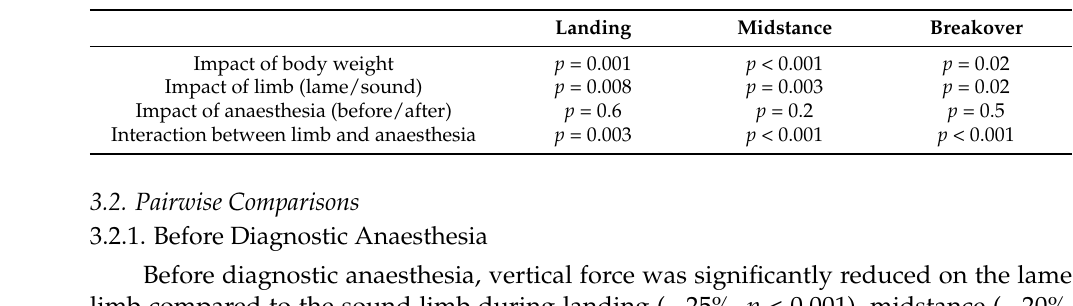
Table 3. Results of the ANCOVA. Global p -values for the repeated measurements limb (lame/sound) and anaesthesia (before/after), as well as their interaction and the covariable body weight during landing, midstance, and breakover.